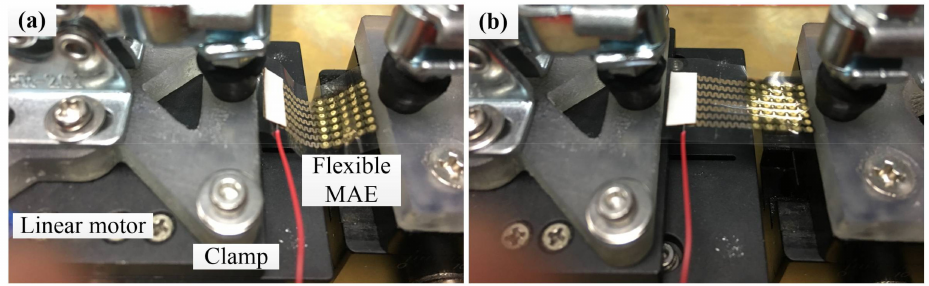
Figure 2. Setup for the flexible MAE bending test. ( a ) Flexible MAE in bending state, ( b ) Flexible MAE in stretching